Question: What does this figure show? Answer in one sentence.
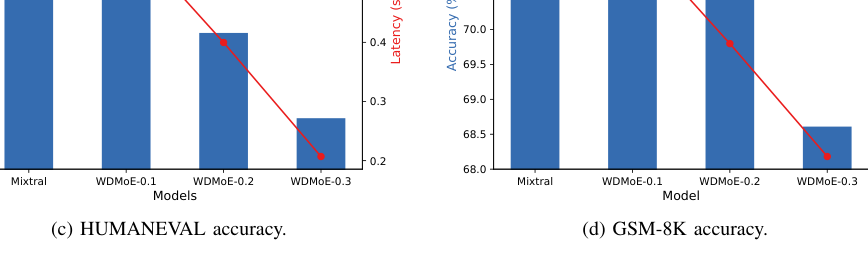
Answer: Performance and latency of WDMoE on various benchmarks.